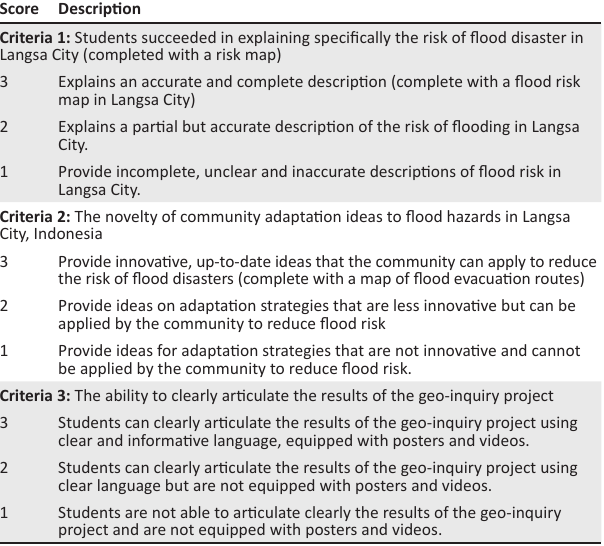
TABLE 1 : Rubric for assessing student learning outcomes in the flood module. Score